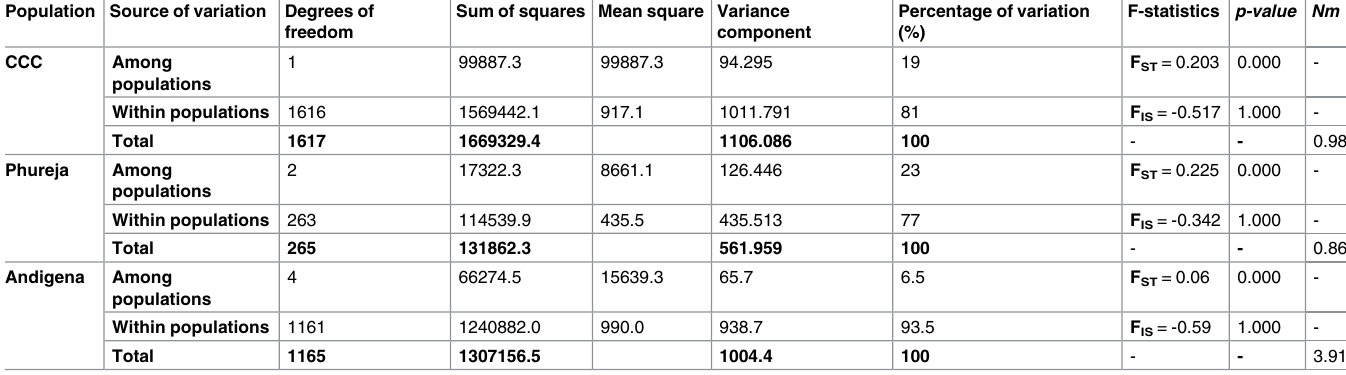
Table 4. Analysis of Molecular Variance (AMOVA) based on SNP markers for each population of S . tuberosum of the Colombian Central Collection. Population Source of variation Degrees of